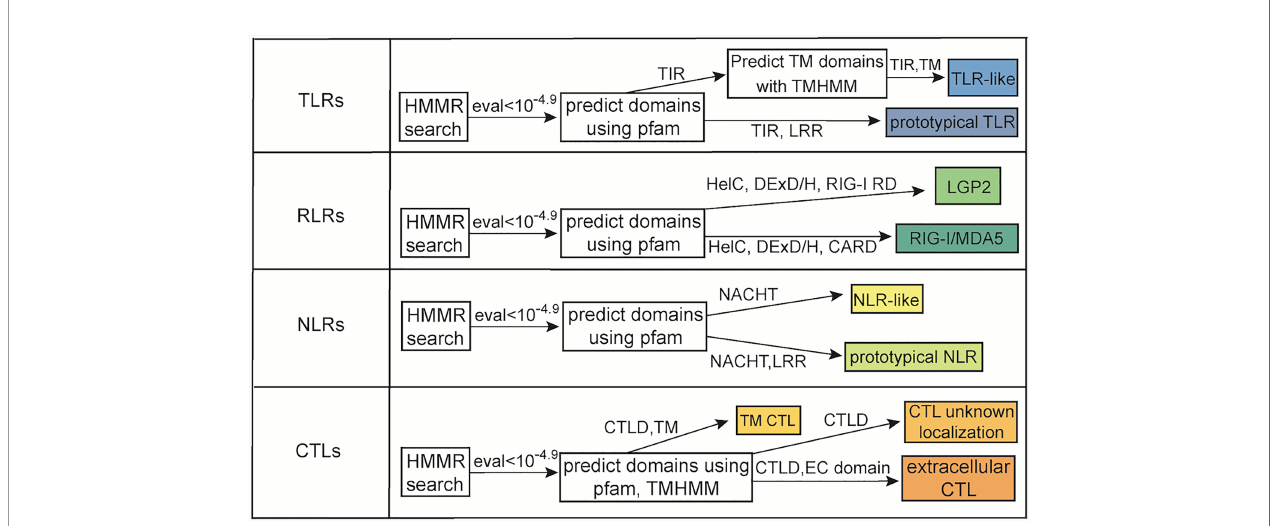
FIGURE 1 | Flow chart of methodology used to identify PRRs. Shown is the minimum domain requirements for a protein to be classi fi ed in the various categories as well as homology requirements based upon